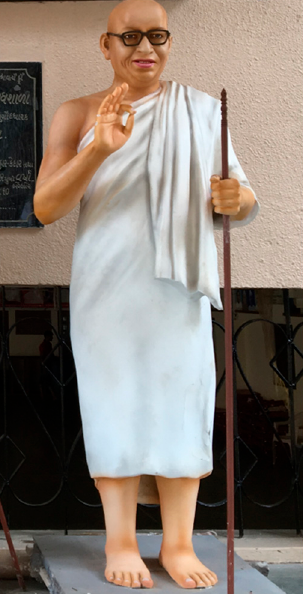
Figure 3. Statue of Ā c ā rya R ā jaya ś as ū ri established in Ahmedabad for his rainy season retreat in